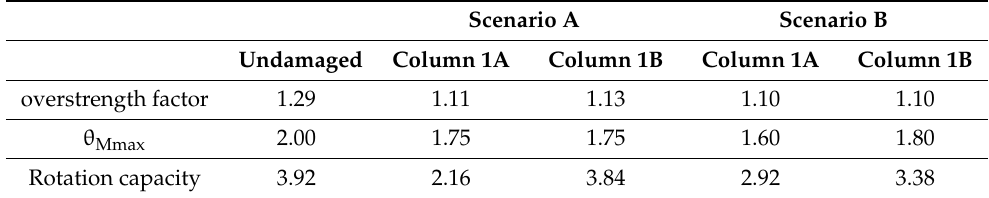
Figure 23. First cycle envelope curves for the moment M x at the base and top end of the heated columns. Table 5. Summary of the behaviour of columns 1A, 1B, and 1C.